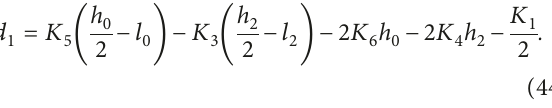
Figure 18: Time history of the resultant hydrodynamic moment about the θ � π /2 axis under the lateral harmonic excitation for z � 0 . 2 m (a), 0.4m (b), 0.6m (c), and 0.8m (d), and r 1